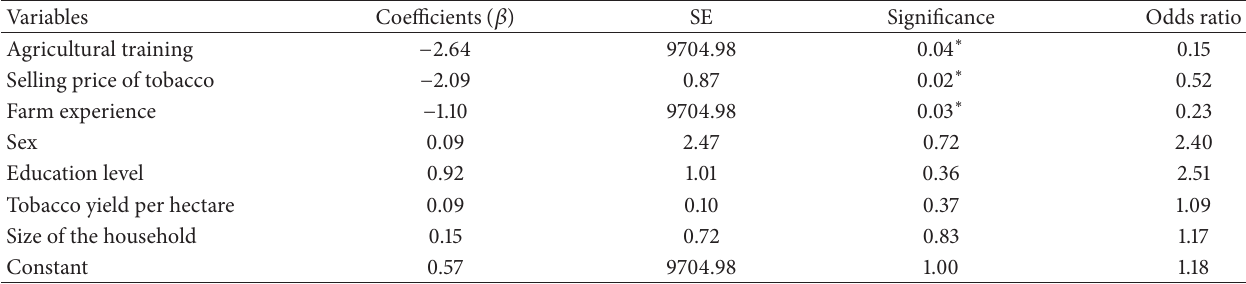
Table 3: Binary logistic regression model for factors influencing natural forest